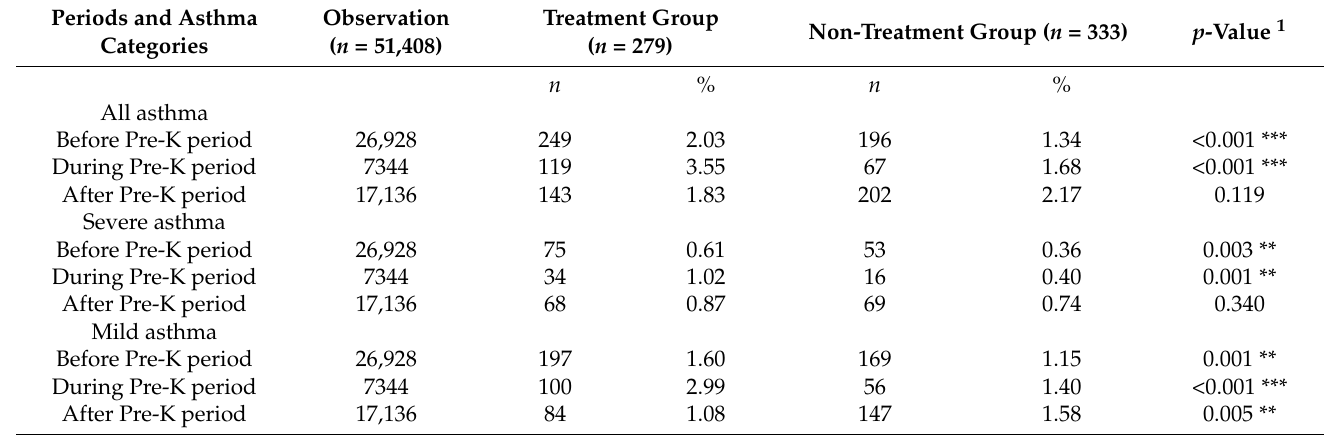
Table 2. Proportion of asthma diagnoses in a person-month unit in three periods.